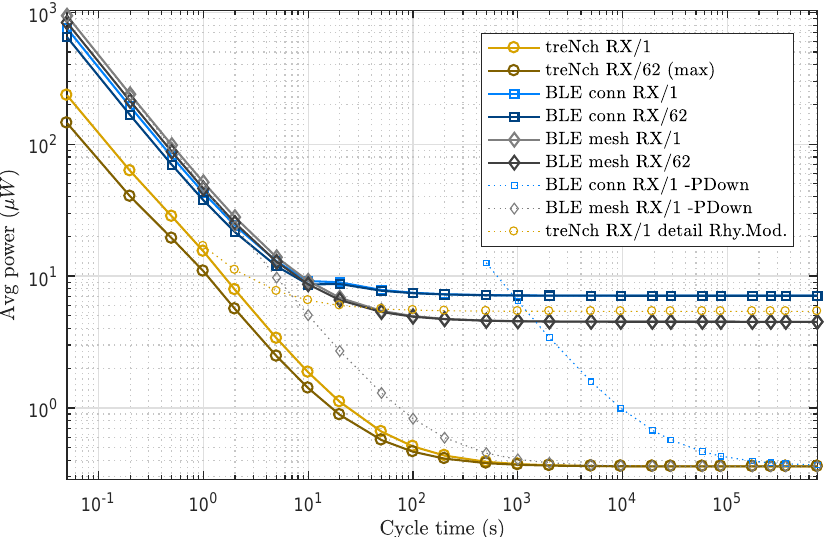
Figure 8. Use case of node with different reception period needs (every N active cycles: RX-Cycle ). Average power of a complete cycle over cycle time. Note logarithmic scale in both axes